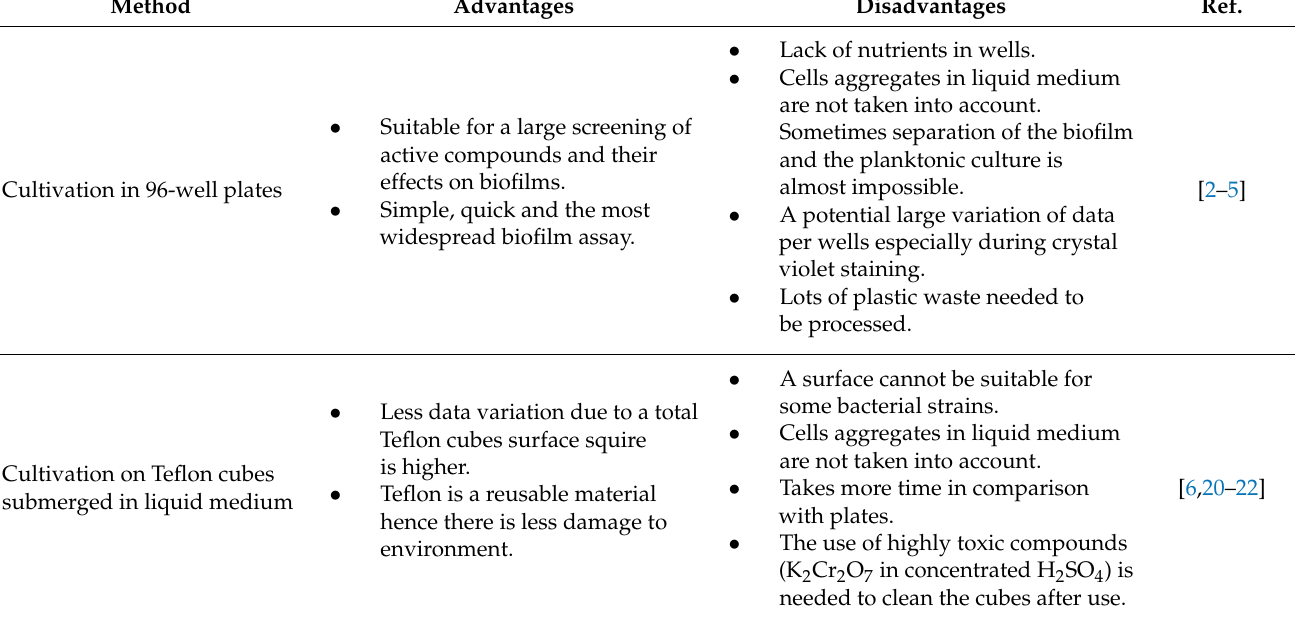
Table 1. Current in vitro models used for cutaneous biofilms assay. Method Advantages Disadvantages